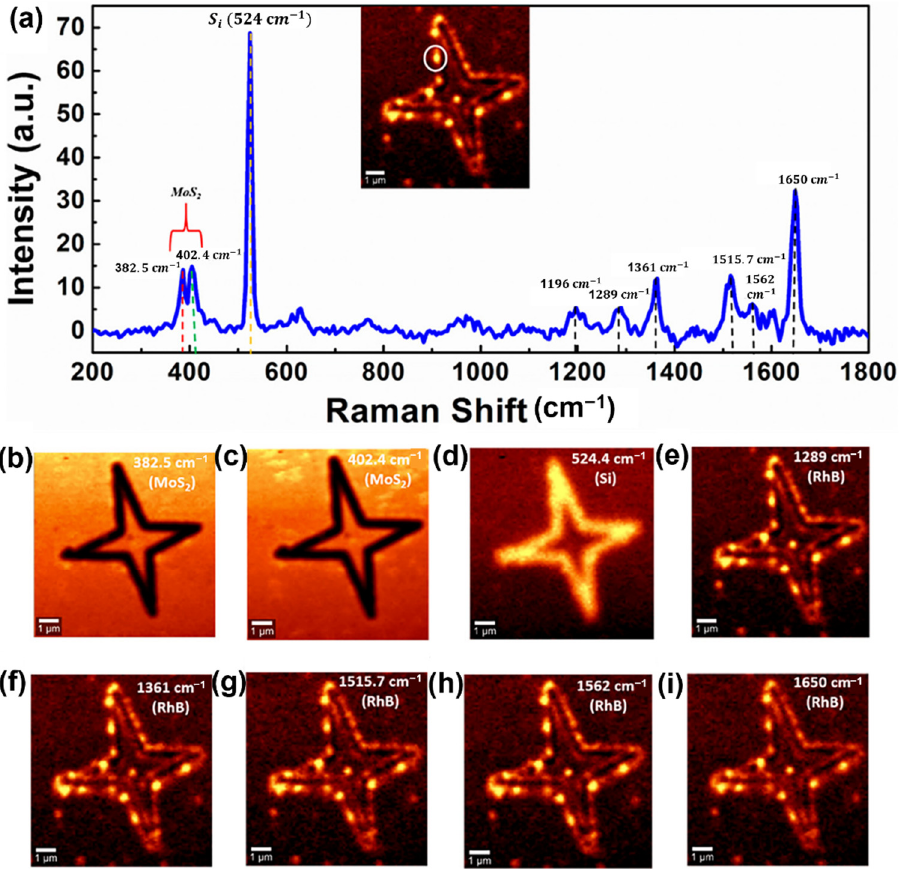
Figure 5. ( a ) Raman peaks of Rhodamine B (black dotted line) and signature signals of MoS 2 (red and green dotted line) and Si (yellow dotted line), obtained at the edge of laser-etched MoS 2 surface modified with Au NPs. ( b – i ) Micromapping images of a star-shaped feature at characteristic peaks of MoS 2 , Si and Rhodamine B, illustrating localized hotspots generated along the factitious edges of the star-shaped nanostructure. Reprinted with permission from ref. [82]. Copyright 2020 American Chemical Society.